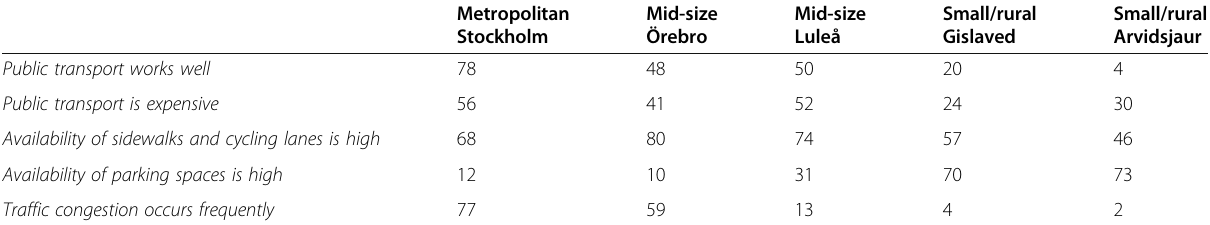
Table 3 Perceptions about infrastructure in selected municipalities (%